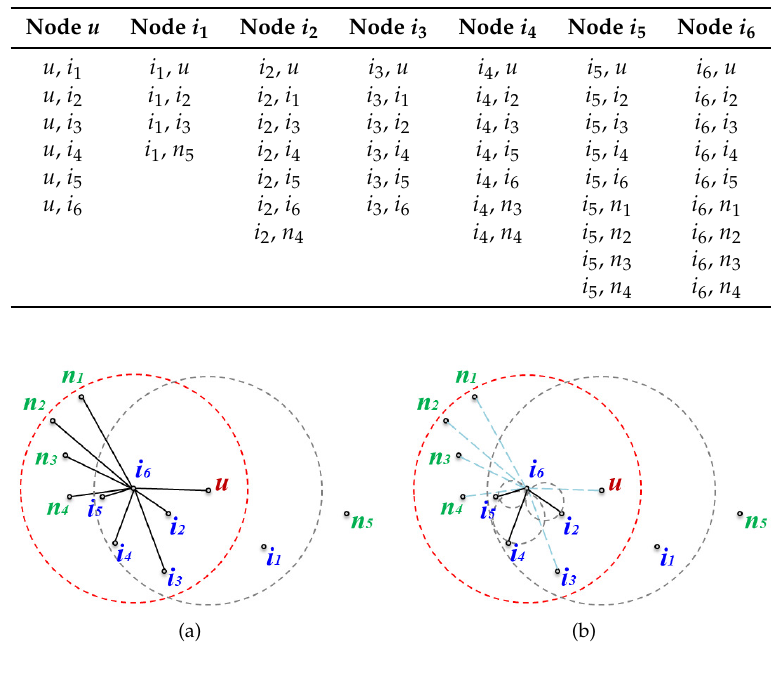
Table 1. The local network graph edge lists of message transfer node u and its neighbors in Figure 3.